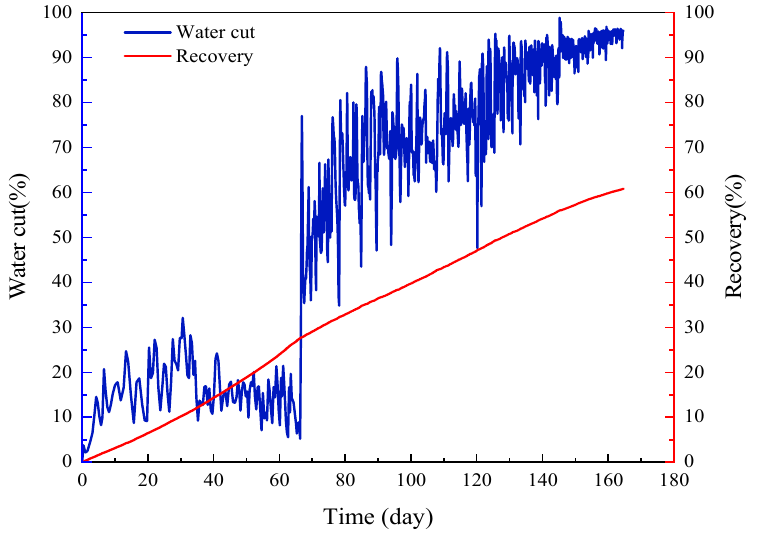
Figure 6. Production curves of bottom water flooding stage.